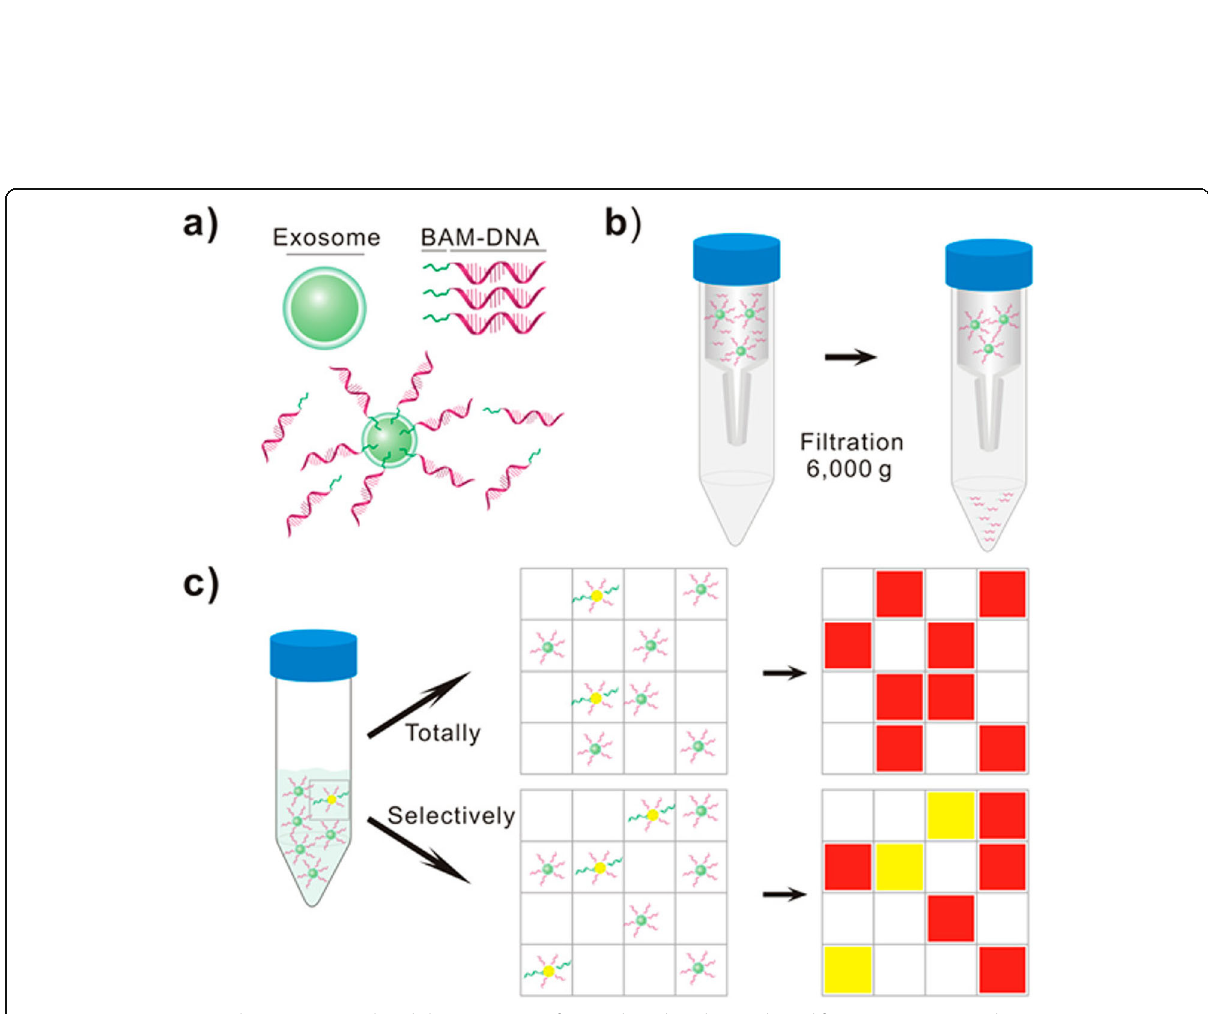
Fig. 5 Exosomes counting by microscopic digital detection via surface-anchored nucleic acid amplification [136]. Copyright© 2018, American Chemical Society